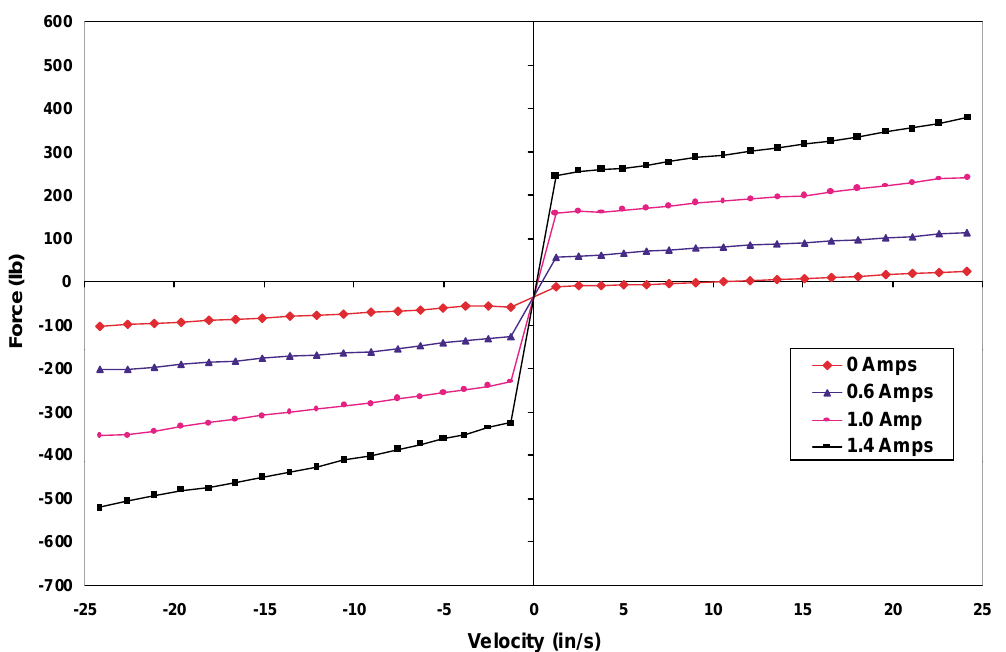
Fig. 5. MR Damper Damping Force